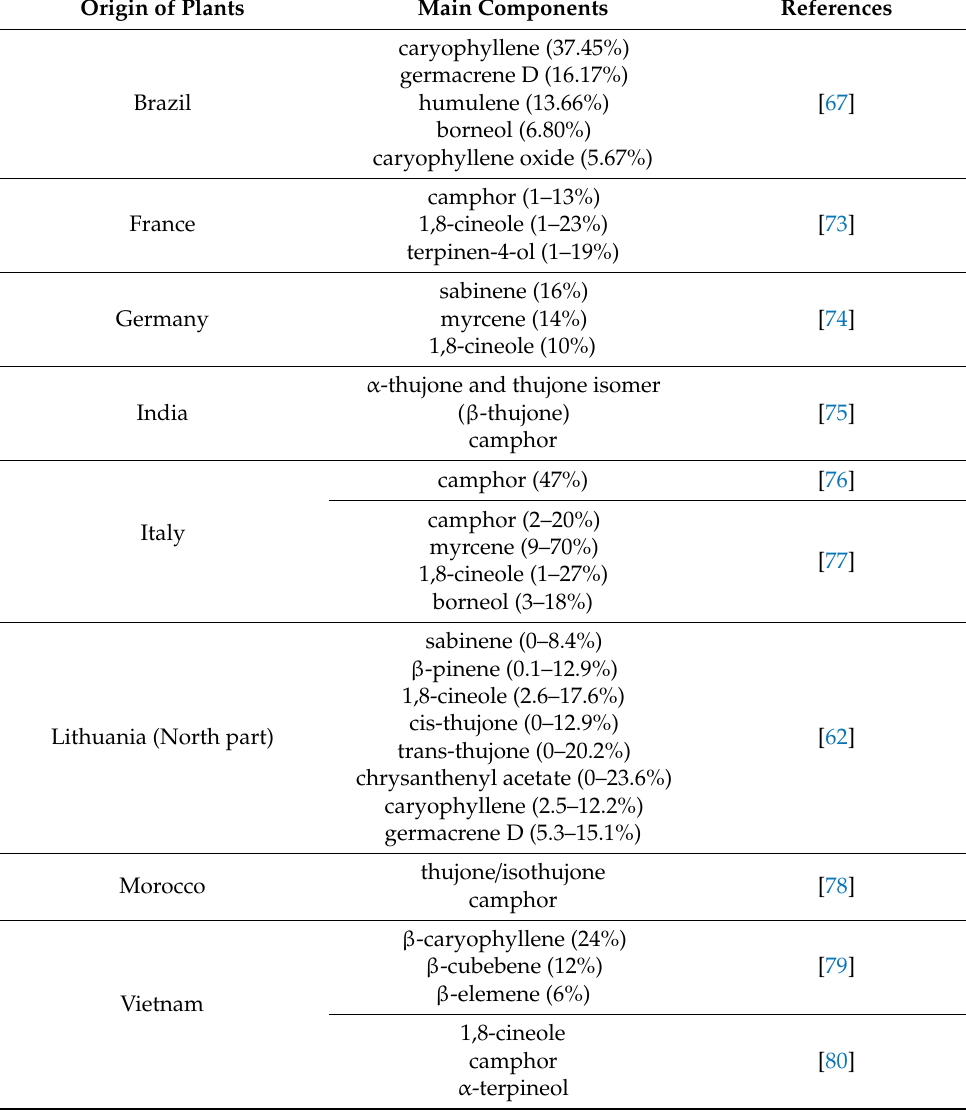
Table 4. Di ff erences in the composition of essential oils from the herb of A. vulgaris of various origins. Origin of